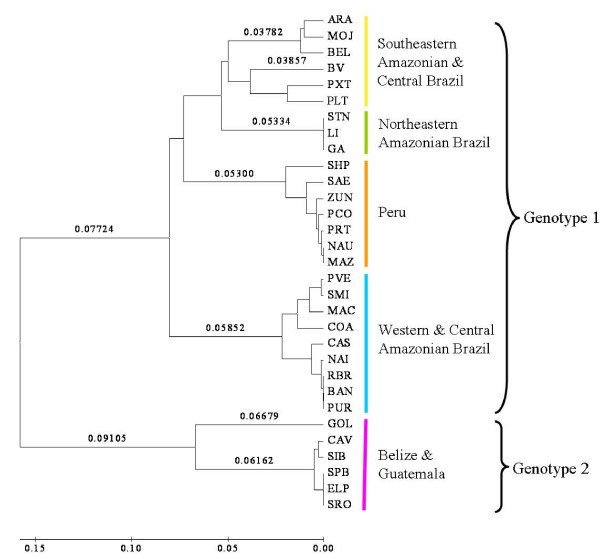
FST distance-based NJ tree of the pairwise comparisons among all populations. The mean pairwise FST values are proportional to the branch lengths (see scale bar). The pairwise estimates of FST were 100% significantly different (P < 0.05 after sequential Bonferroni correction) when samples from the two genotypes and among the five population clusters were compared.